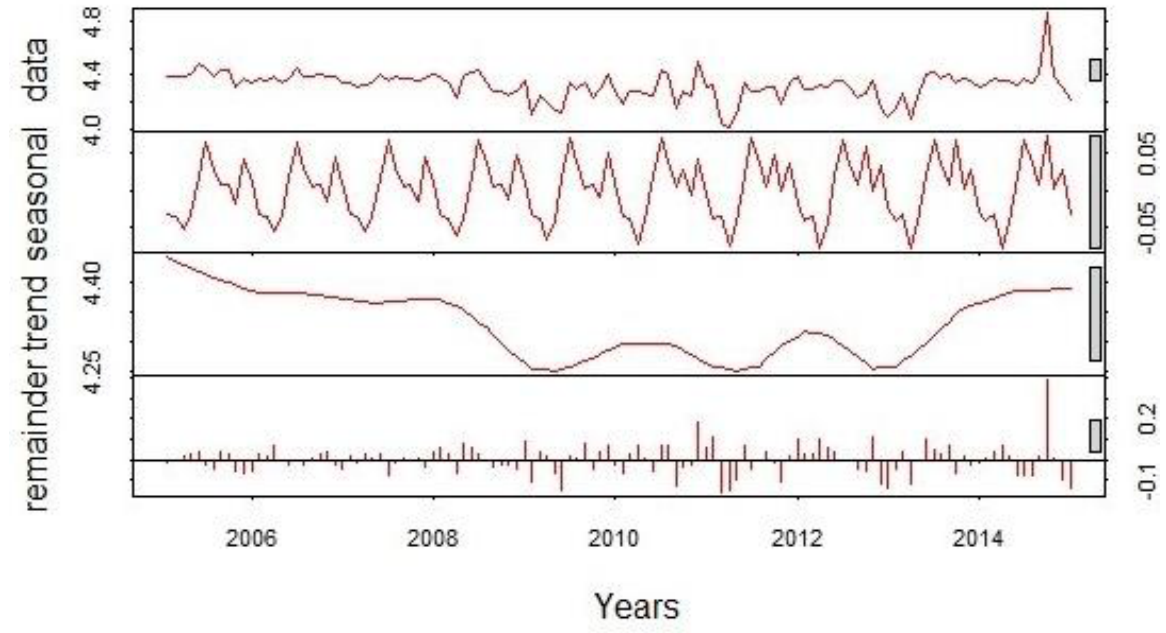
Fig. 3. The additive decomposition of the time series